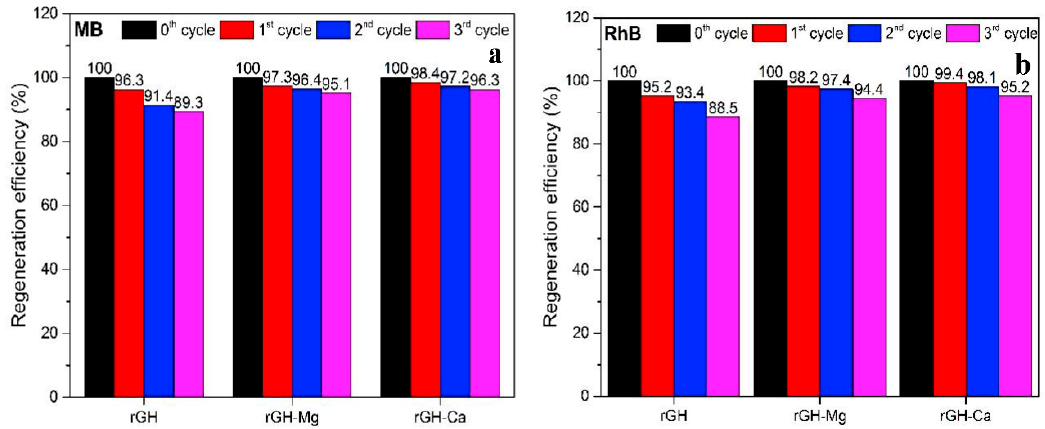
Figure 8. Regeneration efficiency after adsorption of ( a ) MB and ( b ) RhB after 3 cycles.